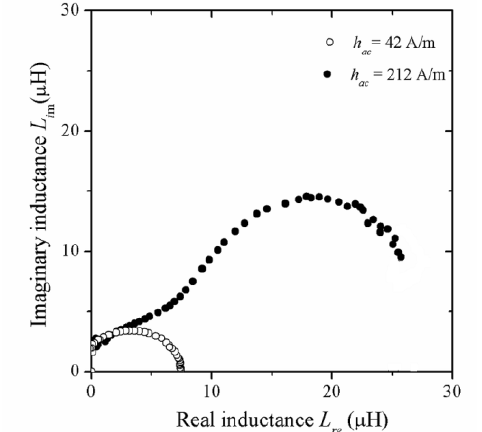
Figure 13. Cole-Cole plots at different h Co Fe B Si Mo Ni 69.7 3.8 13 11 1.5 1